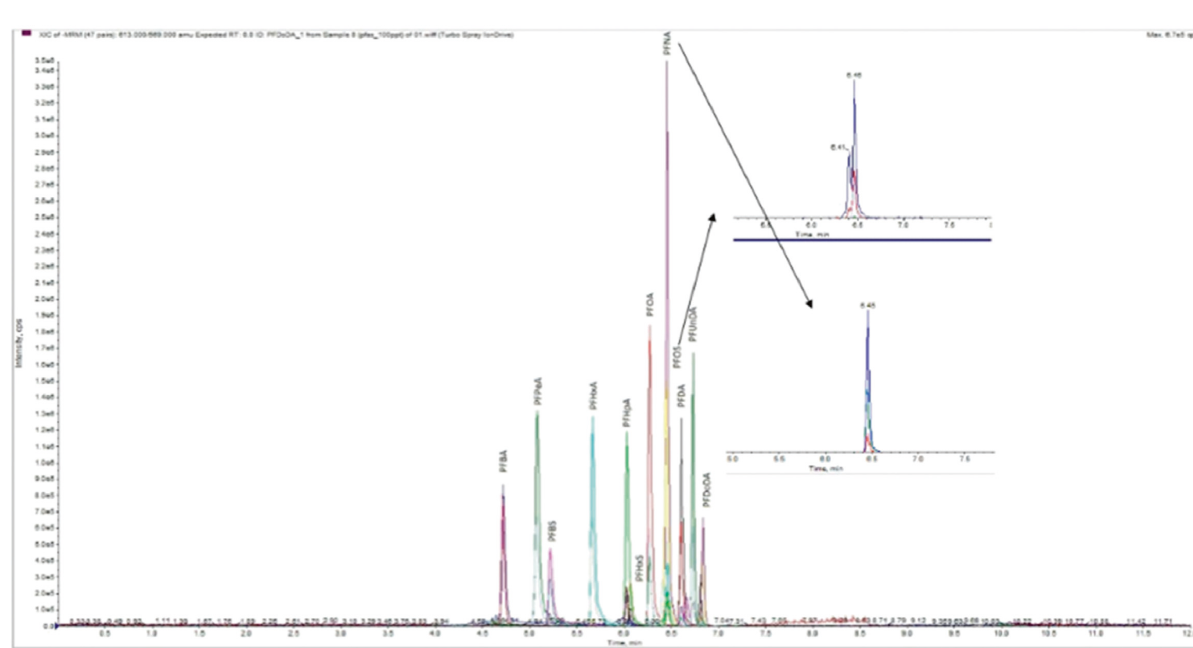
Figure 1: Chromatogram of PFAs solutions at 50ng · L − 1